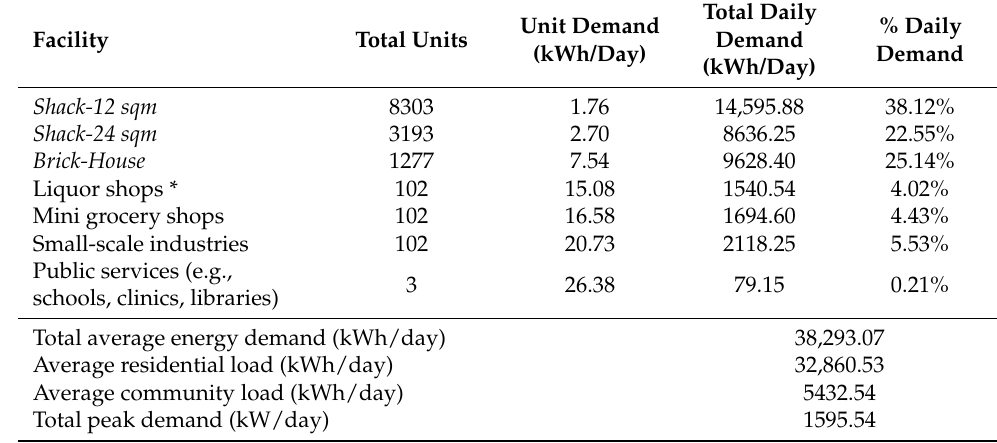
Table 5. Estimated daily load profile for the Havana settlement.